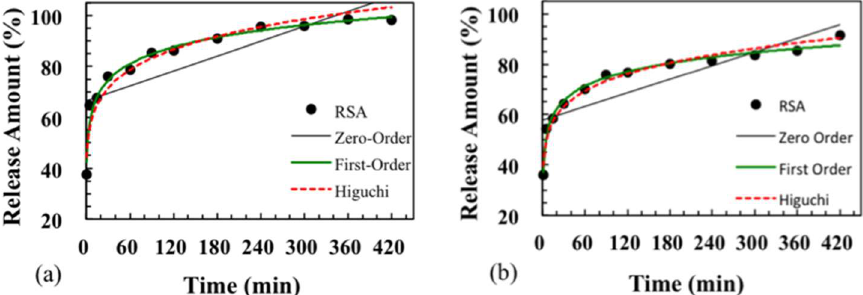
Figure 7. Fitting of released data of RSA in phosphate-buffered solution (pH = 7.4) ( a ) and simulated gastric fluid (pH = 2.0) ( b ) at 37 °C to three different models: zero-order, first-order, and Higuchi model. Table 1. Correlation coe ffi cients of three kinetic models applied to resveratrol released from RSA. Kinetic